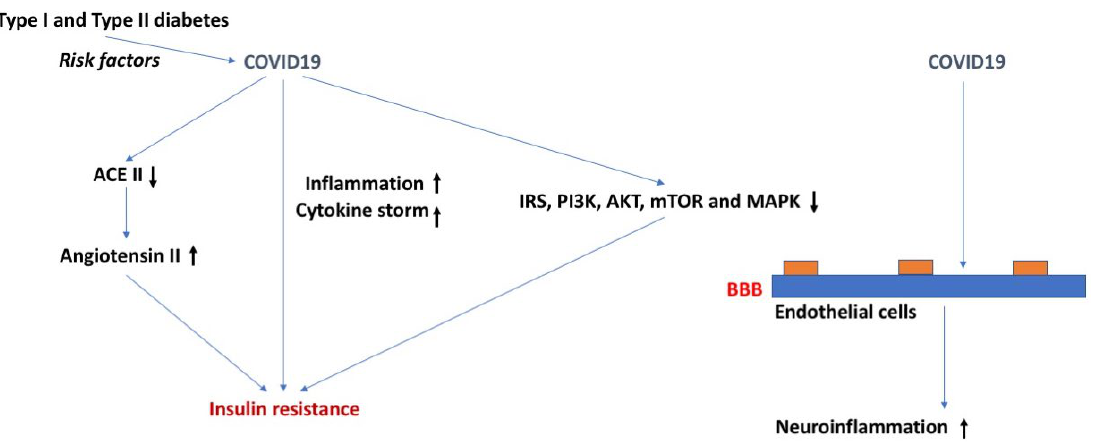
Figure 6. COVID-19, insulin resistance, and the BBB. Type I and type II diabetes are risk factor for COVID-19. COVID-19 might cause insulin resistance via downregulating ACE II and upregulating angiotensin II levels, increased inflammation involving a cytokine storm, or via IRS, PI3K, AKT, mTOR, and MAPK. COVID-19 might induce neuroinflammation through effects on the BBB. The arrows in bold indicate the direction of the effects. For more details, see